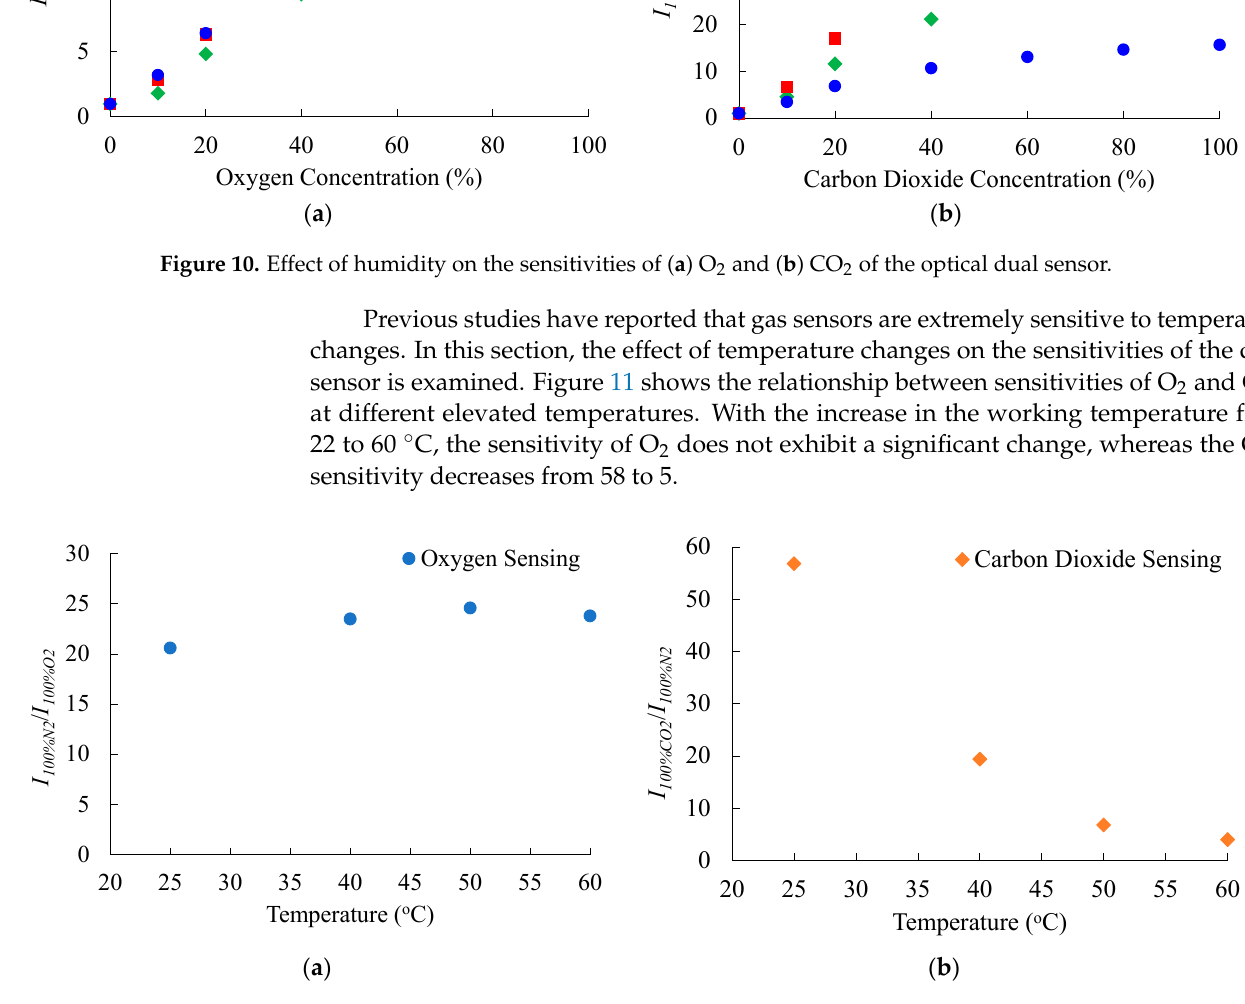
Figure 11. Effect of temperature on the sensitivities of ( a ) O 2 and ( b ) CO 2 of the optical dual sensor.